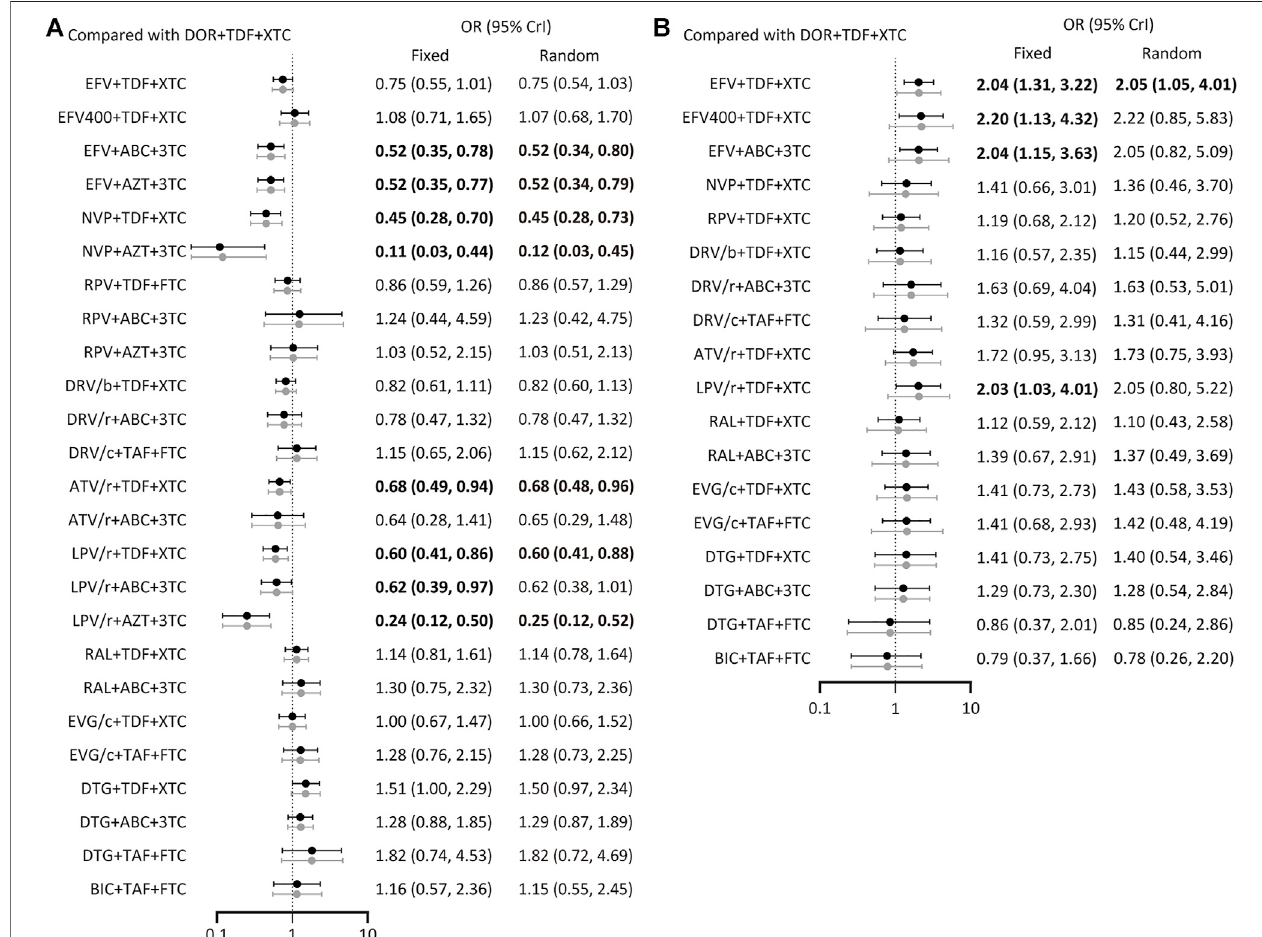
FIGURE 3 | Forest plot of outcomes in terms of (A) virological suppression, (B) adverse events. Results of fi xed effect model were drawn in black, and results of random effect model were drawn in grey. ABC: abacavir; ATV: atazanavir; AZT: Azidothymidine; BIC: bictegravir; c: cobicistat; DOR: doravirine; DRV: darunavir; DTG: dolutegravir;EFV:efavirenz;EVG:elvitegravir;FTC:emtricitabine;LPV:lopinavir;NVP:nevirapine;r:ritonavir;RAL:raltegravir;RPV:rilpivirine;TAF:tenofoviralafenamide; TDF: tenofovir disoproxil fumarate; XTC: emtricitabine or lamivudine; 3TC: lamivudine.